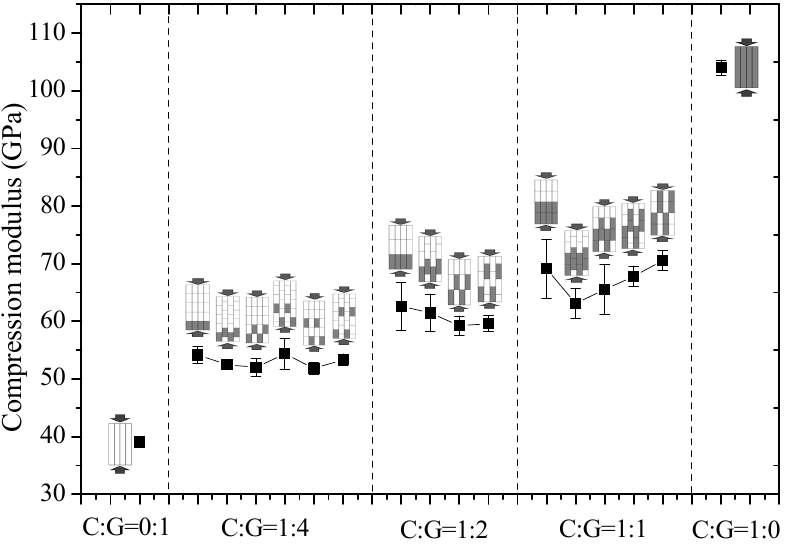
Figure 8. Compression modulus of different stacking sequences with various C/G ratios.